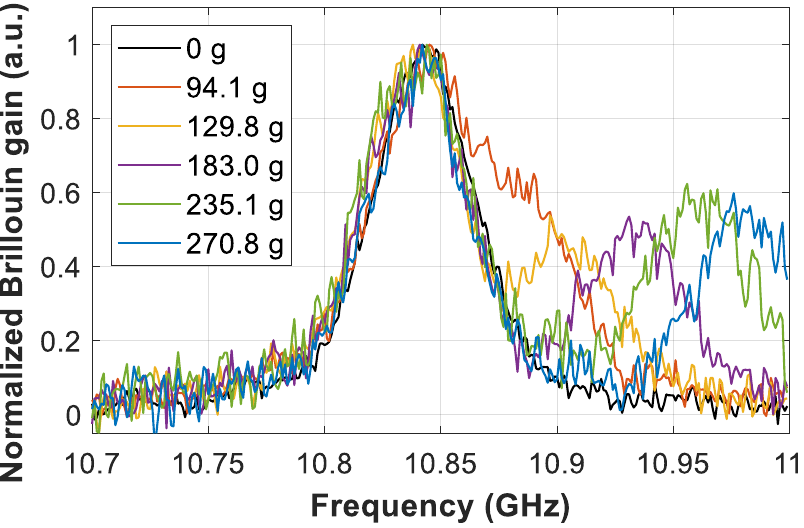
Figure 2. Brillouin spectral measurements obtained at the transition fiber section where strain is applied. Several strains are applied to induce different spectral separations among local Brillouin peak resonances. For the sake of clarity, spectral measurements shown here are obtained with 13 dB SNR.